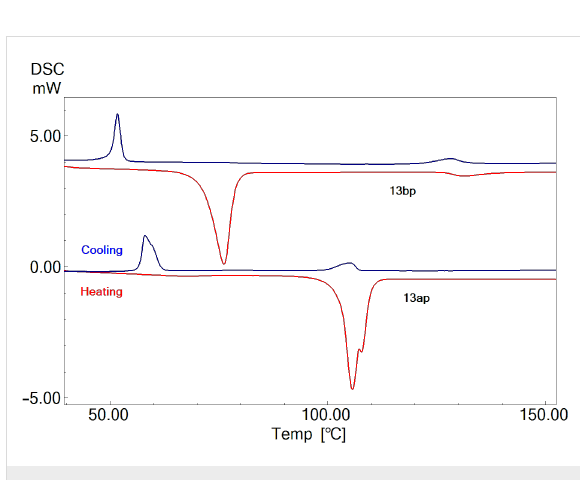
Figure 4: DSC thermograms of 13ap and 13bp